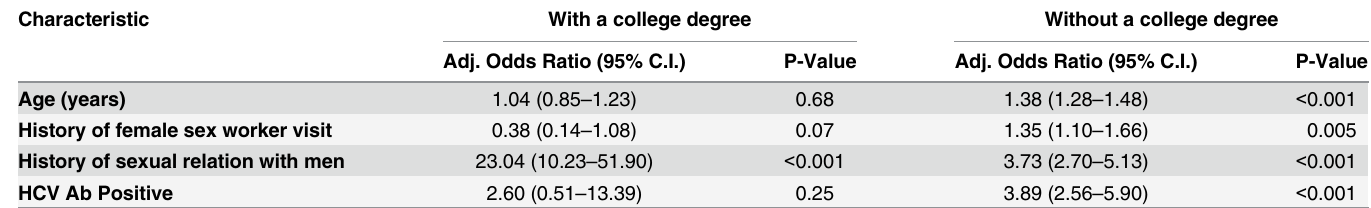
Table 4. Mutivariate analysis of the independent risk factors for HIV